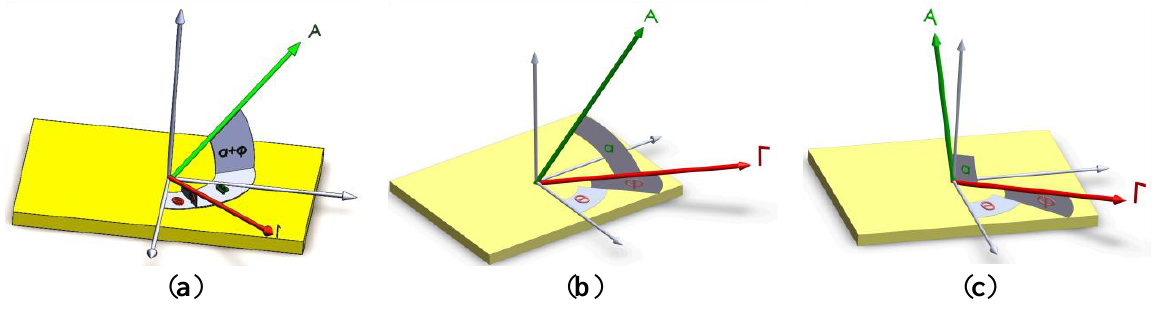
Figure 2. Angular orientation of load A and g-sensitivity vector  of crystal blank. ( a ) Typical state; ( b ) Critical state (β = 0); ( c ) Neutral